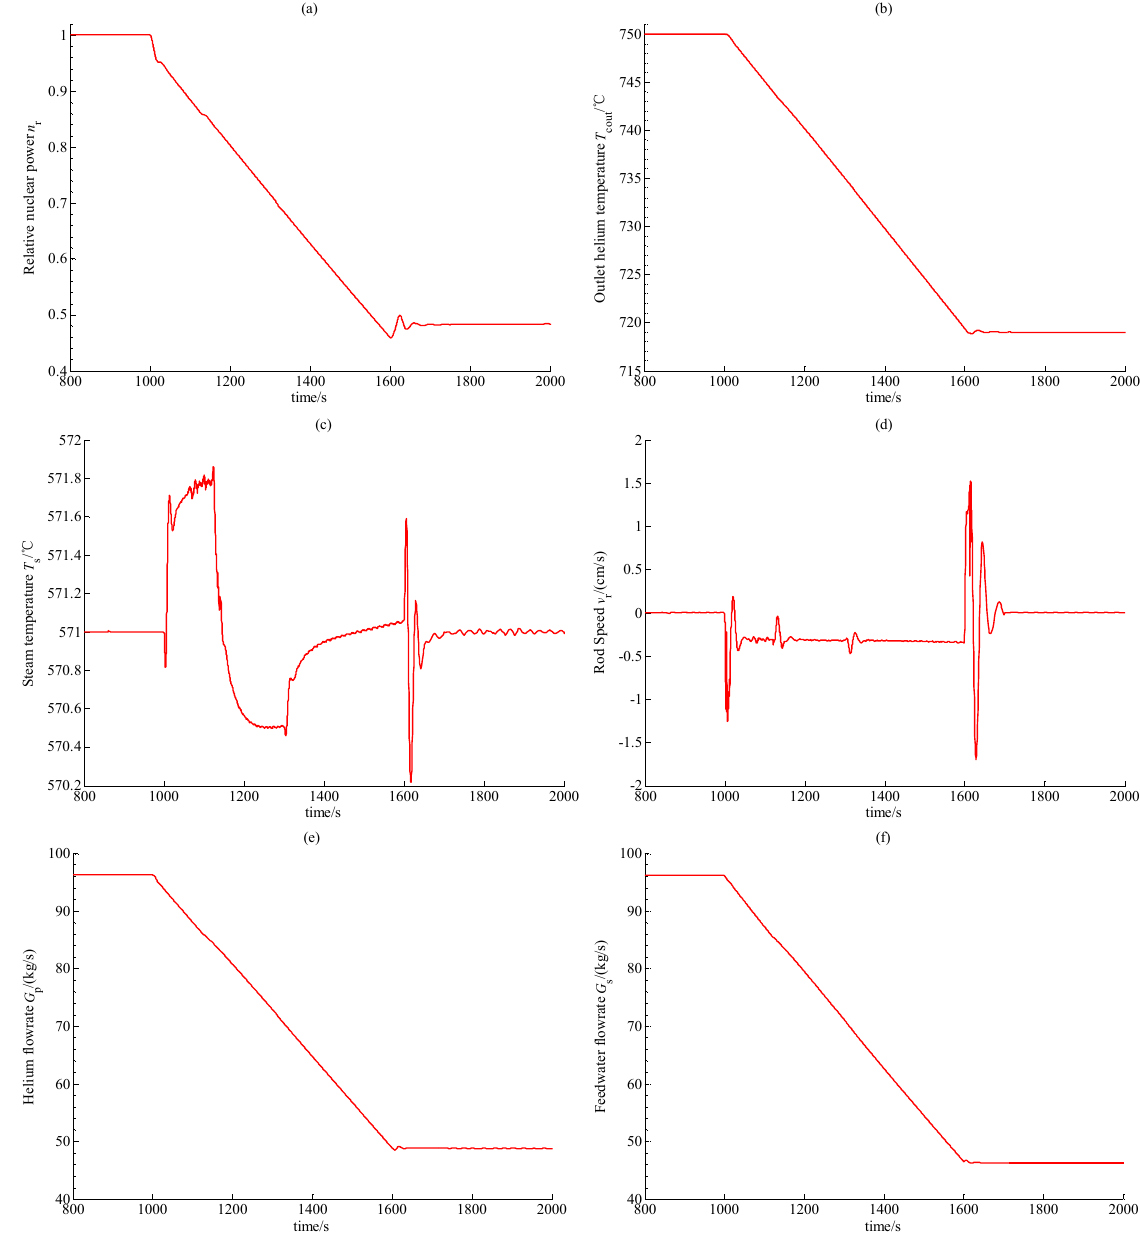
Figure 2. Simulation results in Case A: ( a ) Relative nuclear power; ( b ) Outlet helium temperature; ( c ) steam temperature; ( d ) Control rod speed signal; ( e ) Primary helium flowrate; ( f ) Feedwater flowrate.